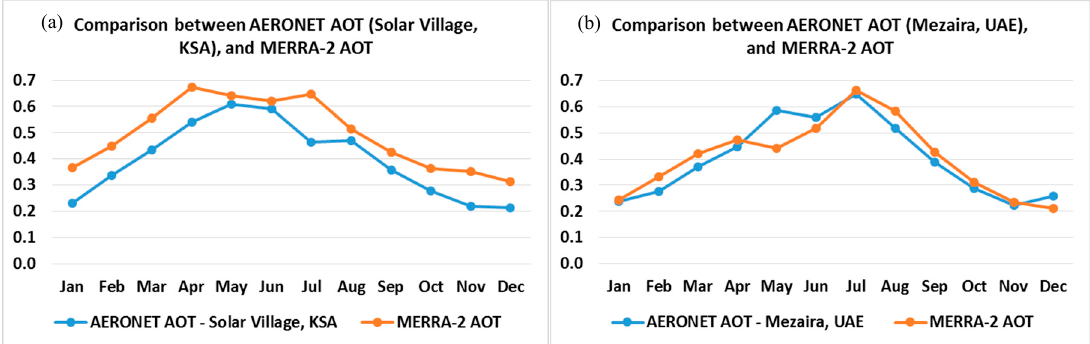
Figure 9. Comparison between AERONET AOT and MERRA-2 AOT in a ) Solar Village, Saudi Arabia (left), and b ) Mezaira, UAE (right).